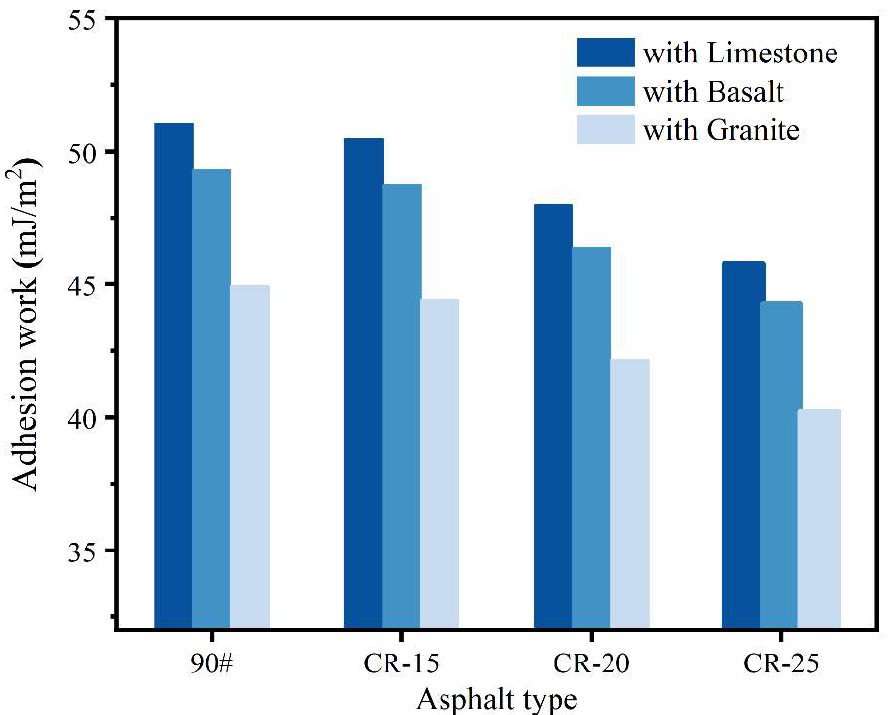
Figure 8. Work of adhesion of different rubberized asphalts.